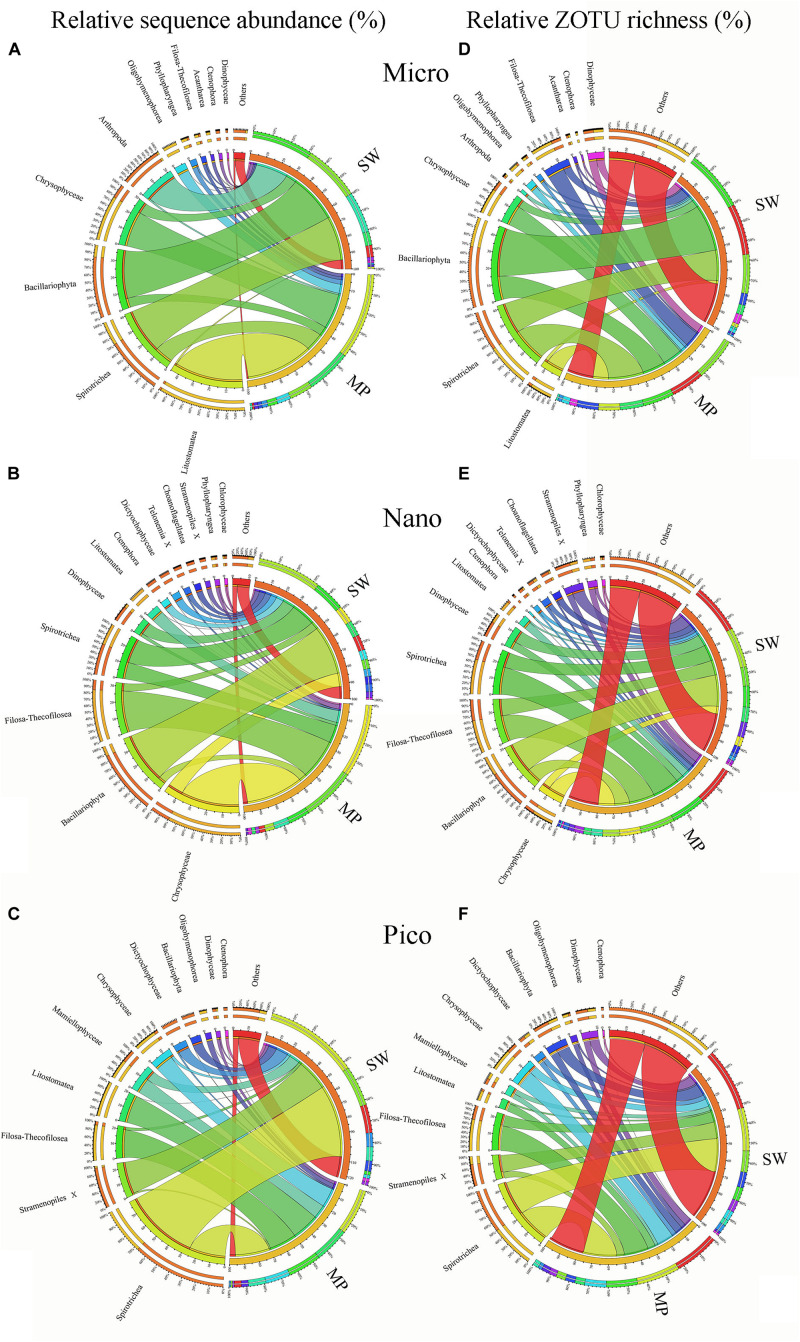
Overview of size-fractionated microbial eukaryotes in the sea water (SW) and melt ponds (MPs). Relative sequence abundance and ZOTU richness of micro- (A,D), nano- (B,E), and pico-sized (C,F) microbial eukaryote subcommunities.